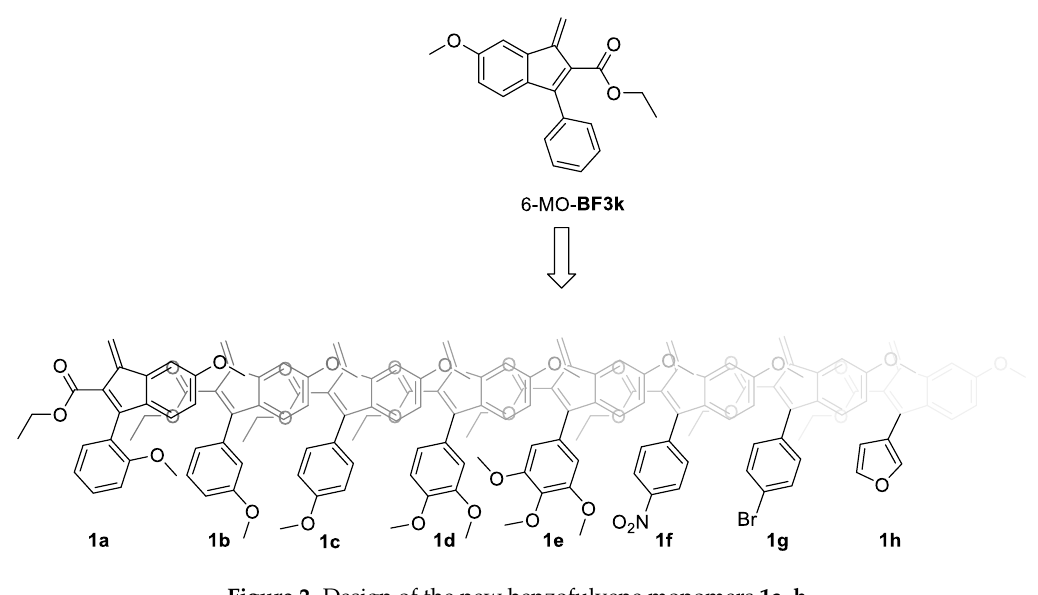
Figure 2. Design of the new benzofulvene monomers 1a – h .